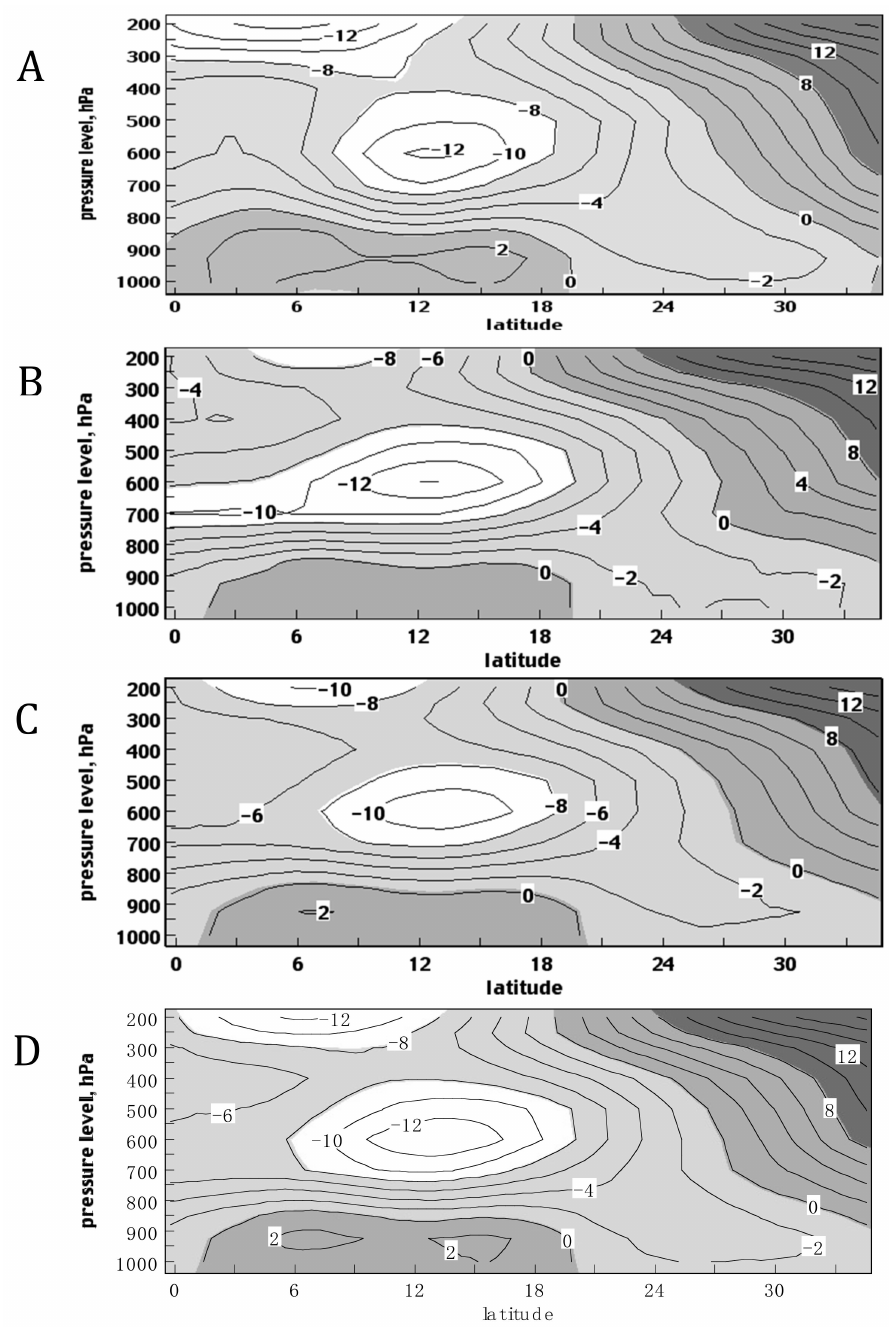
Figure 4. Zonal circulation (m s − 1 ) for June–September 1998–2002, averaged over 10 ◦ W to 10 ◦ E. ( A ) European Centre for Medium-Range Weather Forecasts Interim reanalysis (ERA-I); ( B ) RM3nc forced by ModelE without bias corrections; ( C ) RM3bc forced by ModelE with bias corrections to LBCs and SST; ( D ) RM3sst forced by ModelE with bias corrections to only